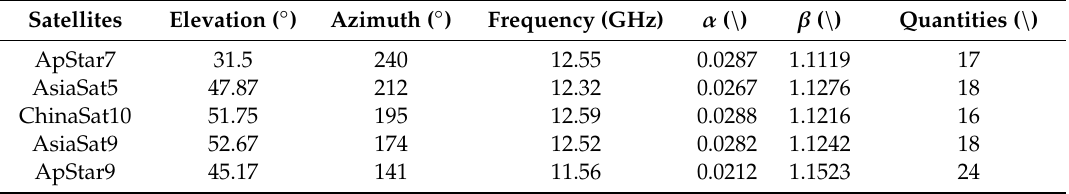
Figure 2. The architecture of OELs network in Jiangning district: ( a ) original distribution of links, and ( b ) rainfall field divided by grid cells where the black line is the OEL and the blue mark denotes the position of inversed rain intensity. Table 1. The parameters of broadcast satellites chosen to build OELs